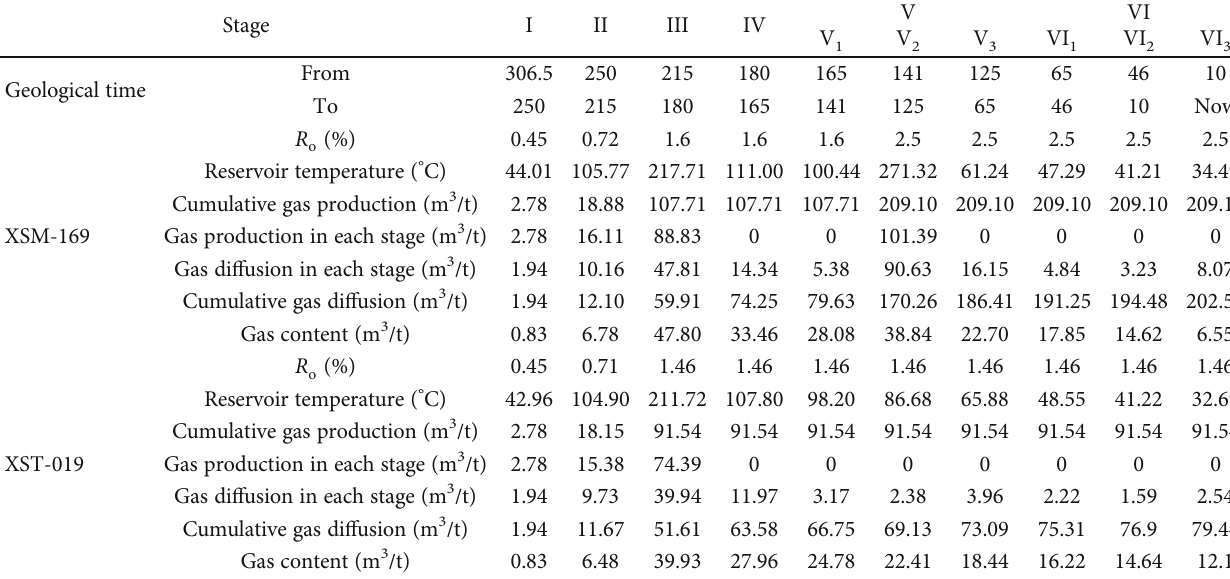
Table 4: The simulation results of the simulation nodes that contain well XSM-169 and XST-019.